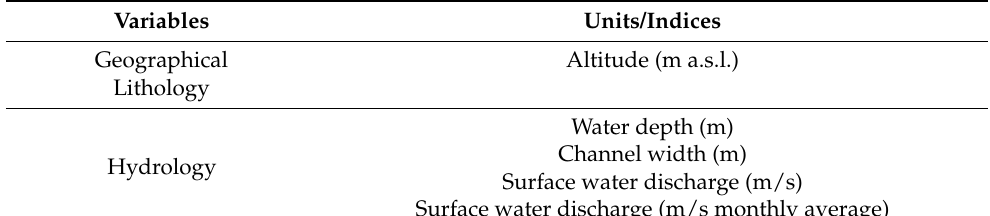
Table 1. Variables used for the analysis in the test